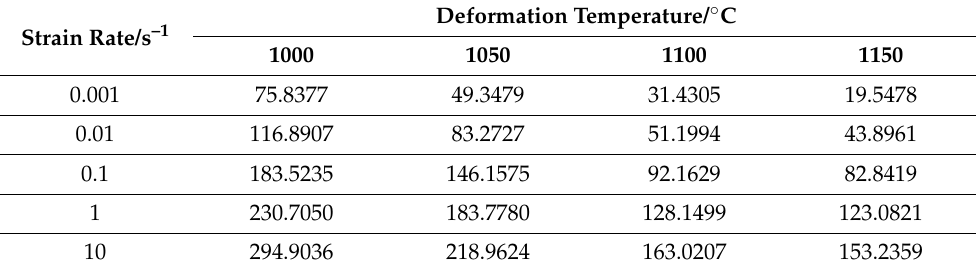
Table 3. Dynamic recrystallization critical stress for S280 steel. Strain Rate/s –1